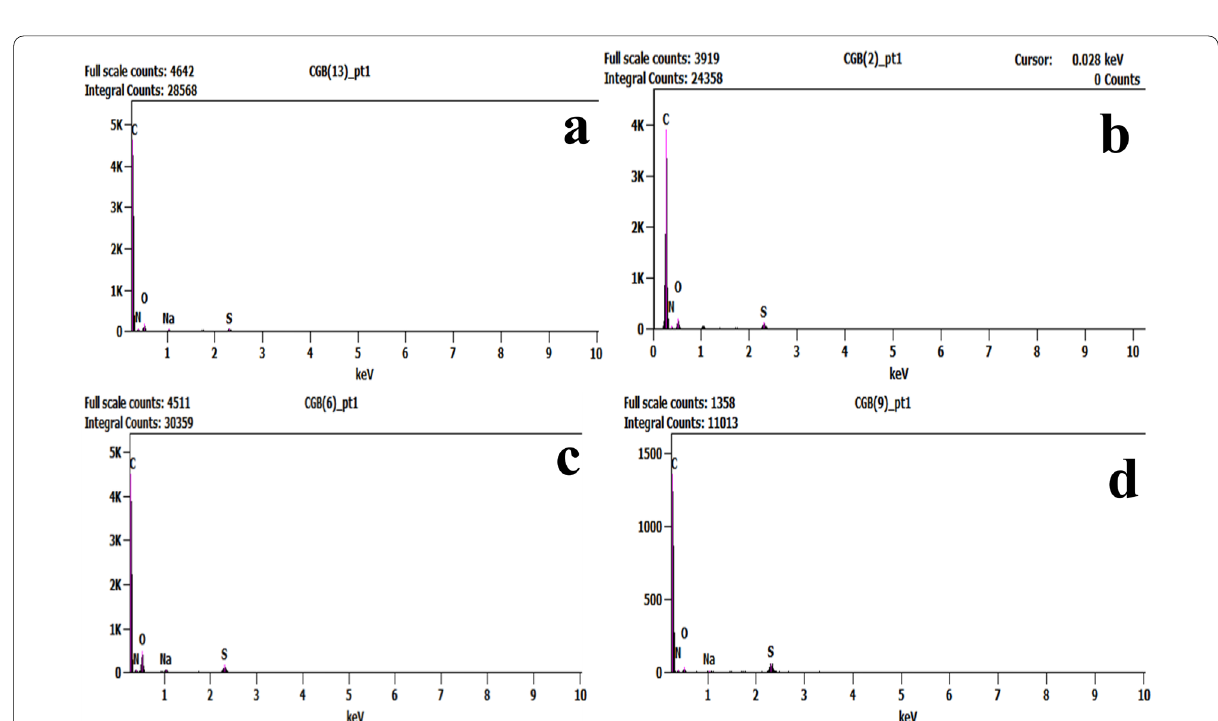
Fig. 4 EDS spectra of the 0.1, 0.2, 0.4 and 1 mM MB electrode confirms that the existence of C, N and